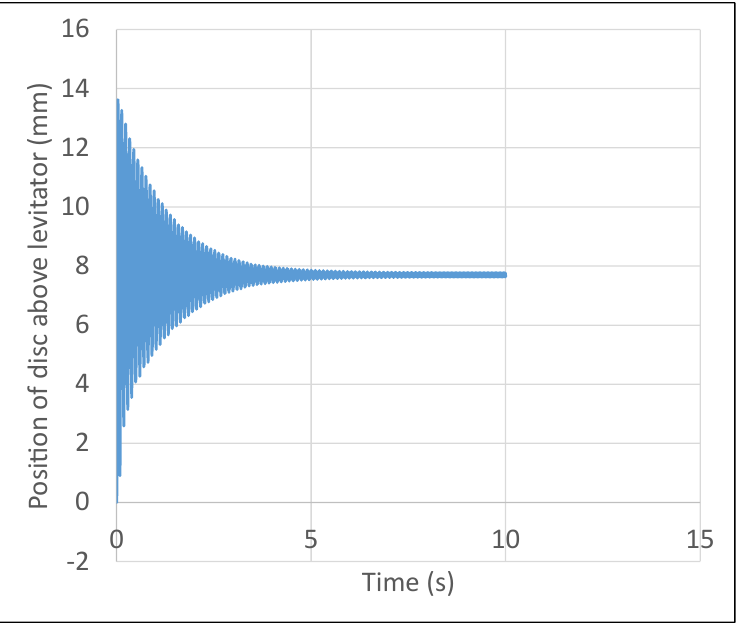
Figure 15. Performance of micromanipulator semi-levitation